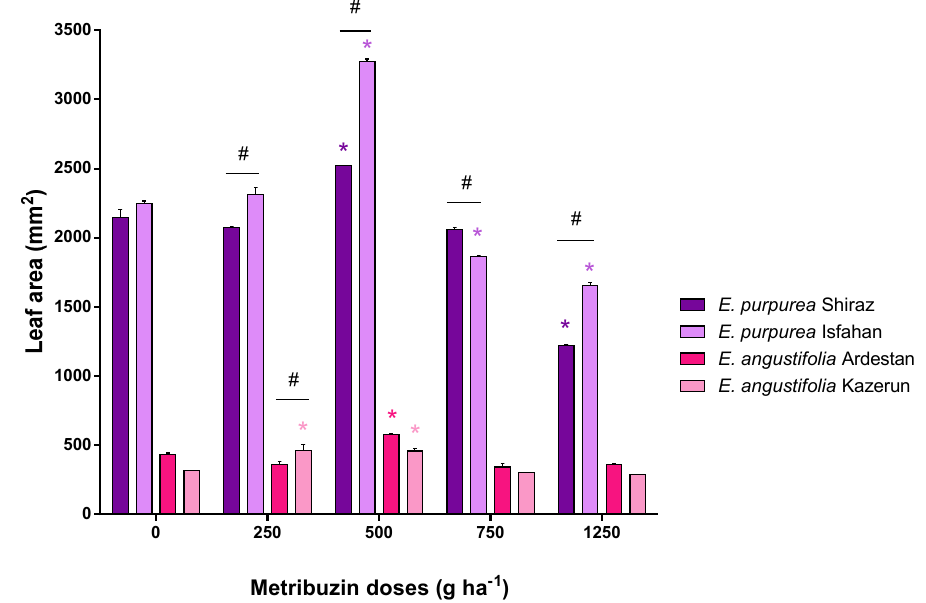
Figure 1. Effect of different metribuzin doses (0, 250, 500, 750, 1250 (g ha − 1 )) on leaf area of Echinacea purpurea and Echinacea angustifolia species. Data are shown as the mean ± SEM, and ordinary two-way ANOVA followed by Dunnett’s multiple comparisons test was used for statistical significance; * p < 0.005 vs. control (0 g ha − 1 metribuzin). Significant differences between Echinacea cultivars are indicated with #.